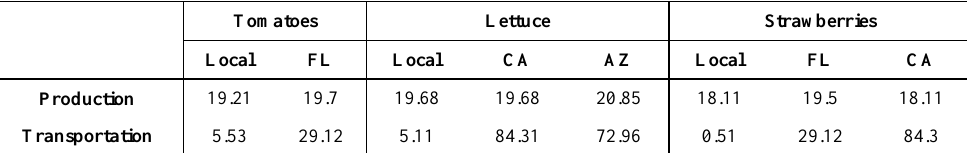
Table 4. Breakdown of GHG100 emissions (kg) by product and